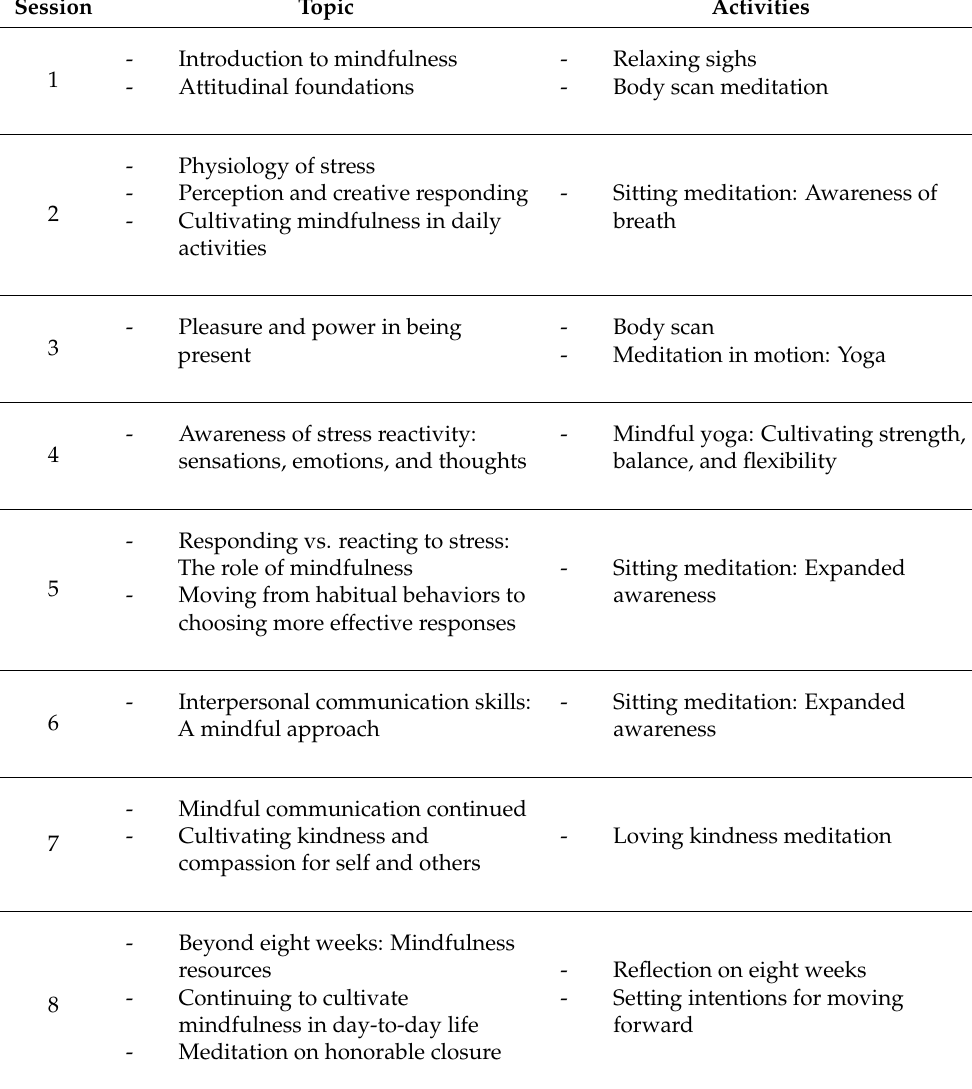
Table 1. Program